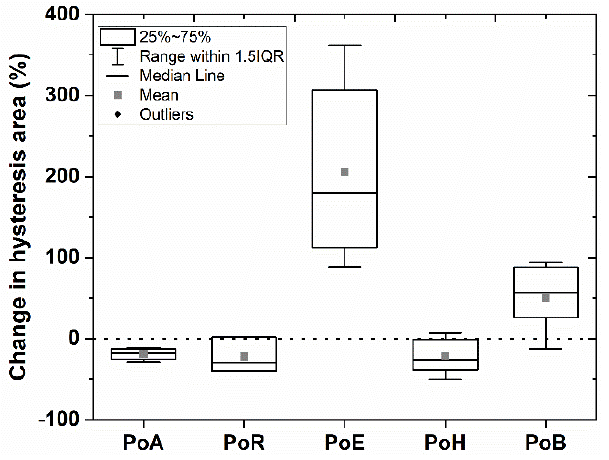
(cid:16) degraded – fresh (cid:17) × 100 × 100(cid:4673) of mud samples from of mud samples from different fresh (cid:3033)(cid:3045)(cid:3032)(cid:3046)(cid:3035)